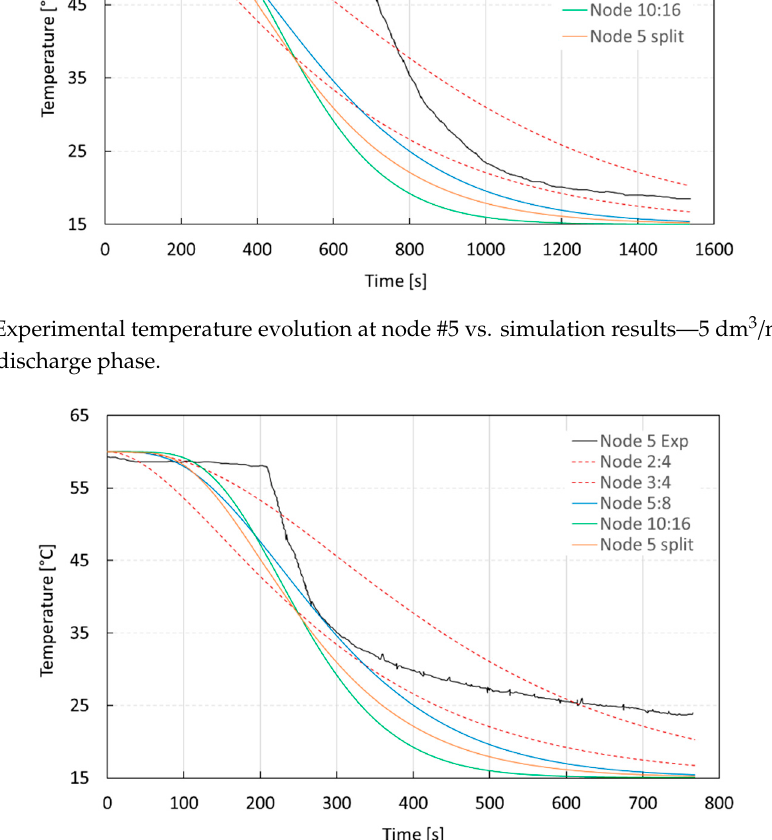
Figure 22. Experimental temperature evolution at node #5 vs. simulation results—15 dm 3 /min volume flow rate—discharge phase. To better investigate the effects of flow rate variations on temperature evolution, three different simulations were performed, each one keeping the number of nodes equal to that considered in the experimental model (N = 8). When observing the temperature evolution of the tank for a flow rate of 5 dm 3 /min (Figure 17), the time temperature evolution for node #8 is comparable to the experimental data. The mismatch slightly increases as it continues toward the upper nodes. It is clear that node #1, being the furthest from the fluid inlet, has a slower response to heat exchange because it is the last one to interact with the cold inlet (then its dynamics is affected by all the other nodes with which the heat exchange takes place beforehand). That trend is reversed with an increase in the inlet flow rate (Figures 18 and 19) in the sense that the higher the flow rate the better the curve representing node #1 fits the experimental data and vice versa for those representing the lower nodes (nodes #5 and #8). As a matter of fact, by observing Figures 18 and 19 compared to the above-mentioned Figure 17, it can be noted that the dynamic behavior becomes faster and faster (as a greater mass of fluid exchanges heat with the water mass in the tank). The temperature at node #8 takes around 300 s for a 15 dm 3 /min volume flow rate, about 400 s and 800 s for a 10 dm 3 /min and 5 dm 3 /min volume flow rate, respectively, to reach the injected flow temperature (i.e., 15 °C). Looking at the experimental curves, even after the unit replacement time (i.e., the time required to replace the whole water mass in the tank) has passed, the water temperature does not reach the